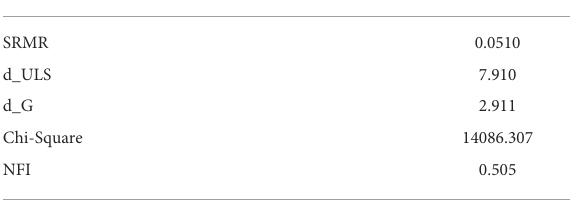
TABLE 4 Model fit summary (N-1200).